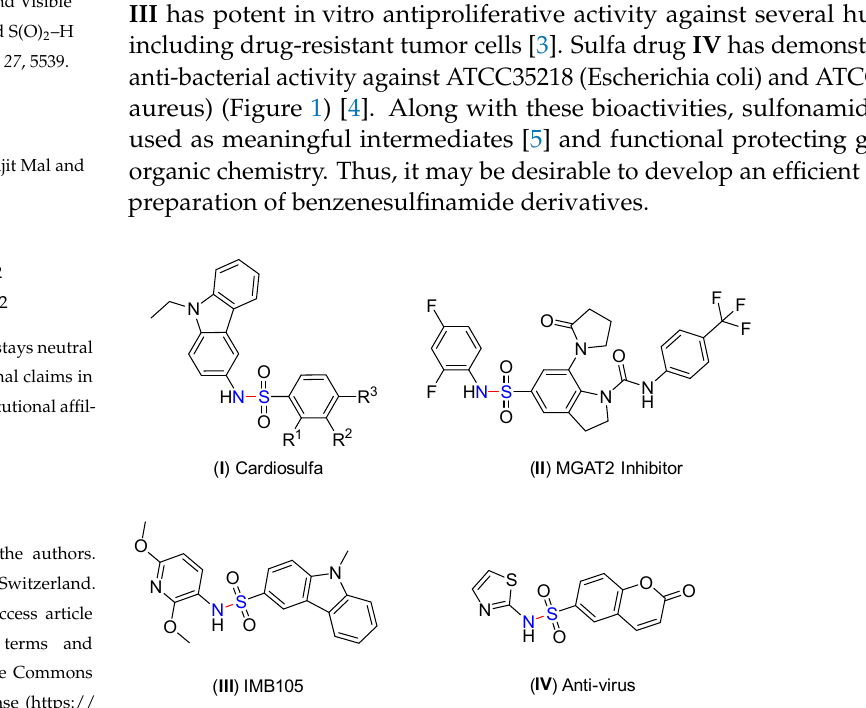
Figure 1. Selected examples of bioactive sulfonamide